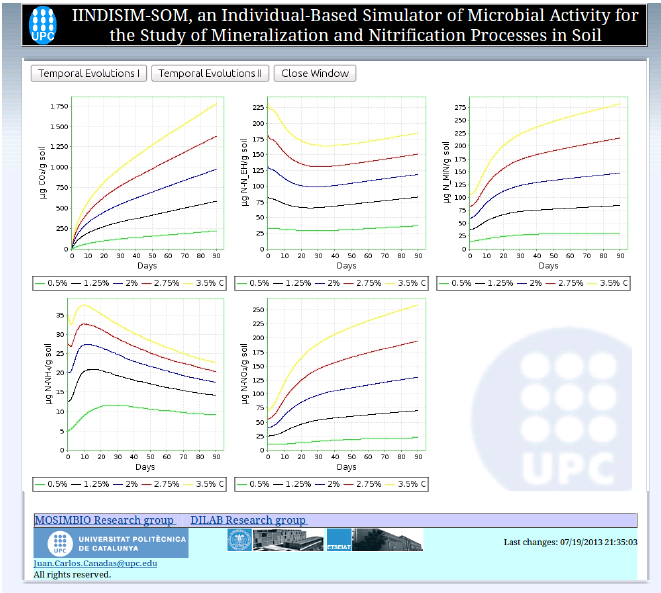
Figure 2. Temporal evoluton of C and N mineralizaton and nitrificaton variables for virtual soils with, 0.5, 1.25, 2.0, 2.75 and 3.5 % of C. Net producton of CO